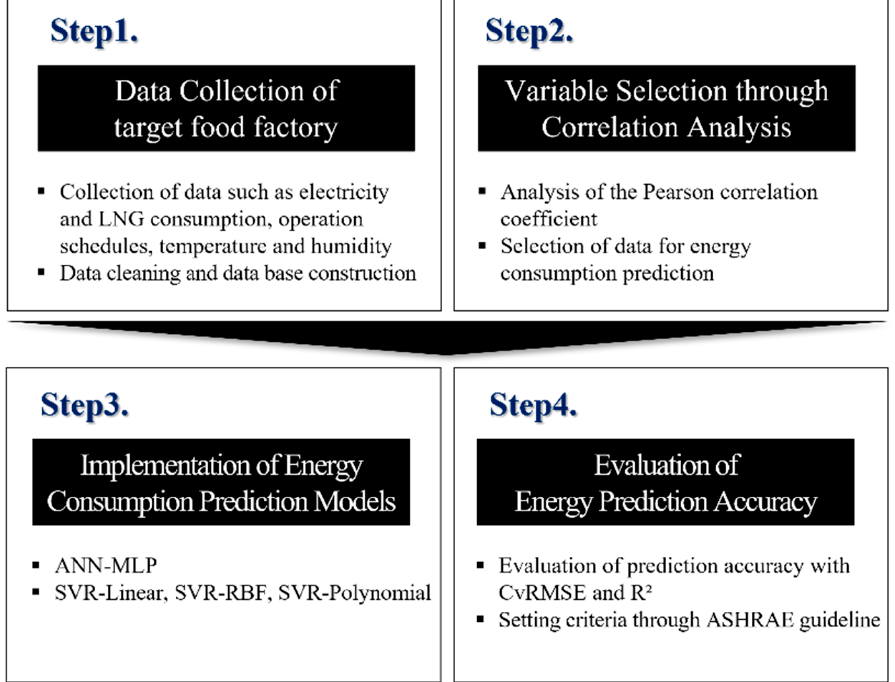
Figure 5. Research